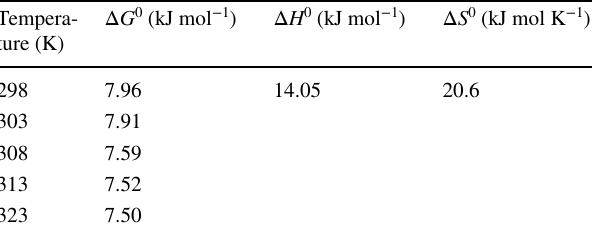
Table 4 Thermodynamic parameters for arsenic adsorption on modi- fied saxaul ash Tempera- ture